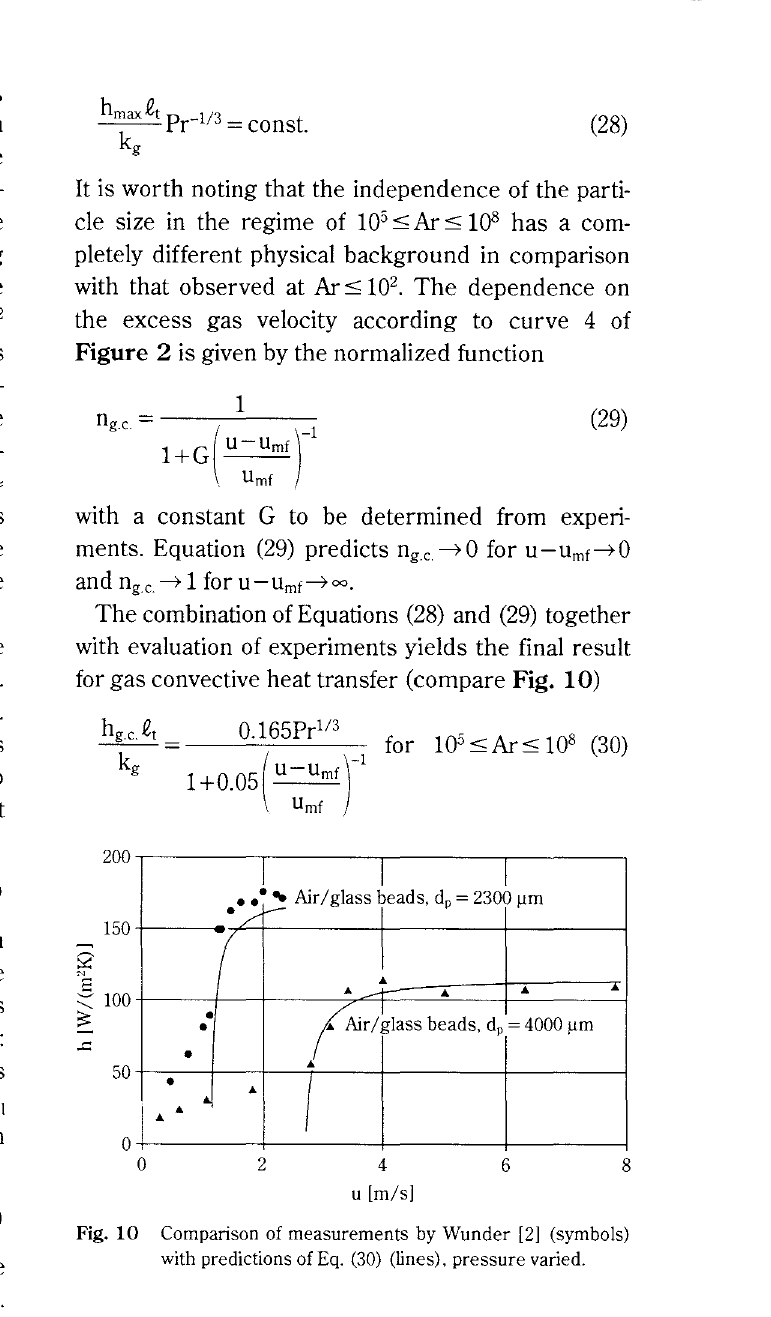
Fig. 10 Comparison of measurements by Wunder [2] (symbols) with predictions of Eq. (30) (lines). pressure